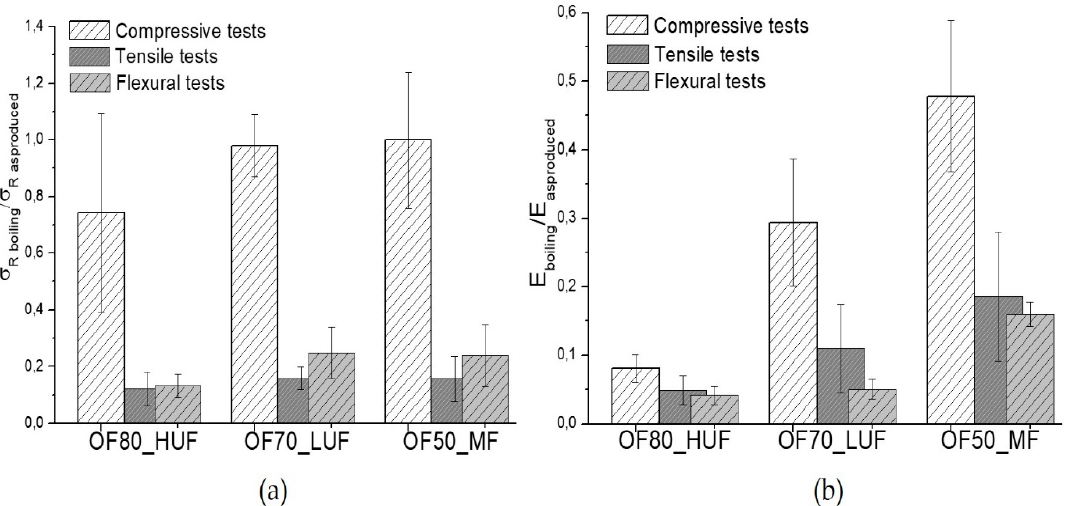
Figure 5. Mechanical response of OF80_HUF, OF70_LUF and OF50_MF samples after the boiling tests; ratio between strength of the samples after and before the boiling tests ( a ), ratio of samples’ modulus after and before the boiling tests ( b